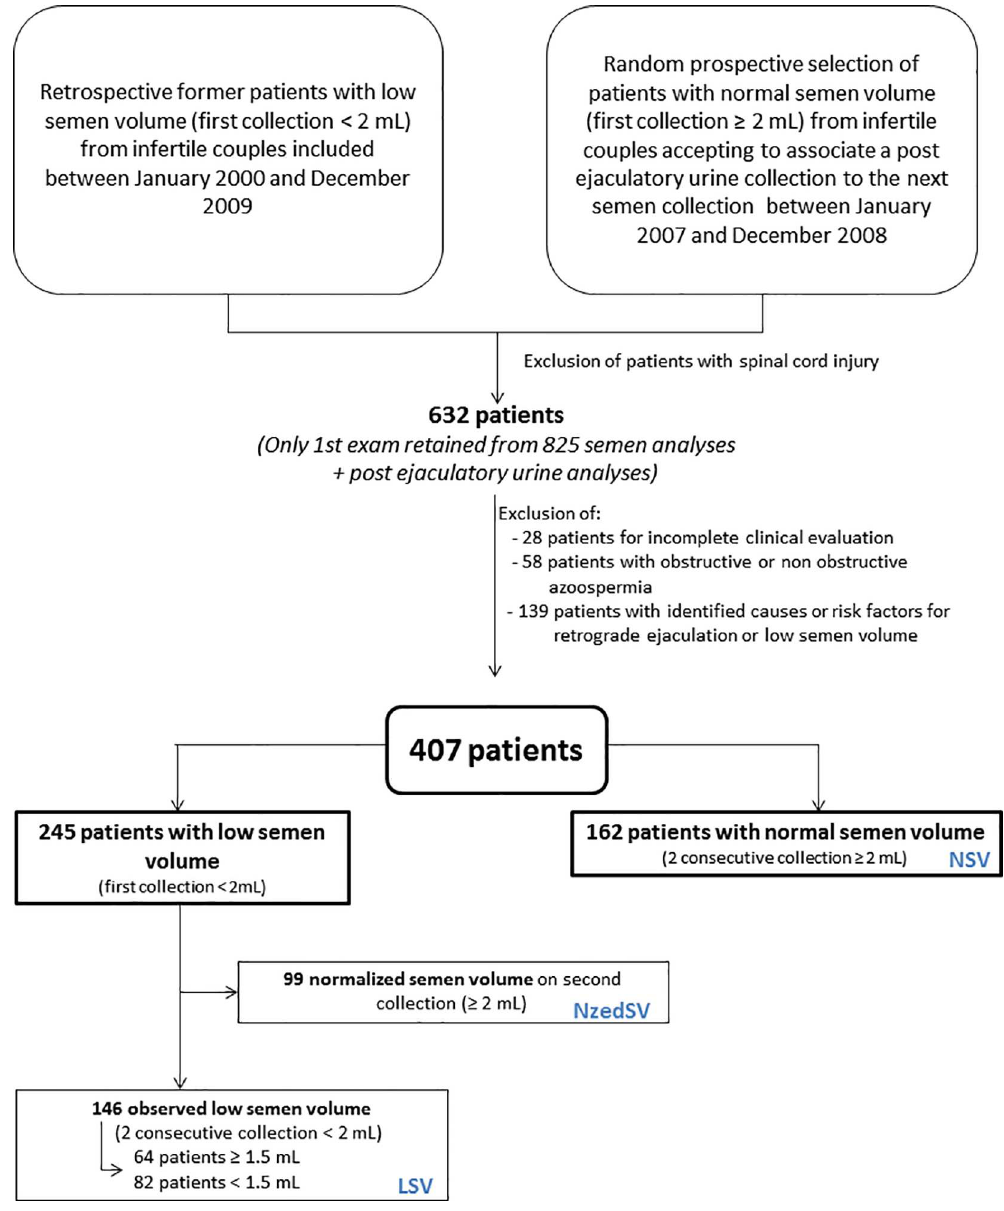
Fig 1. Flowchart and design of the